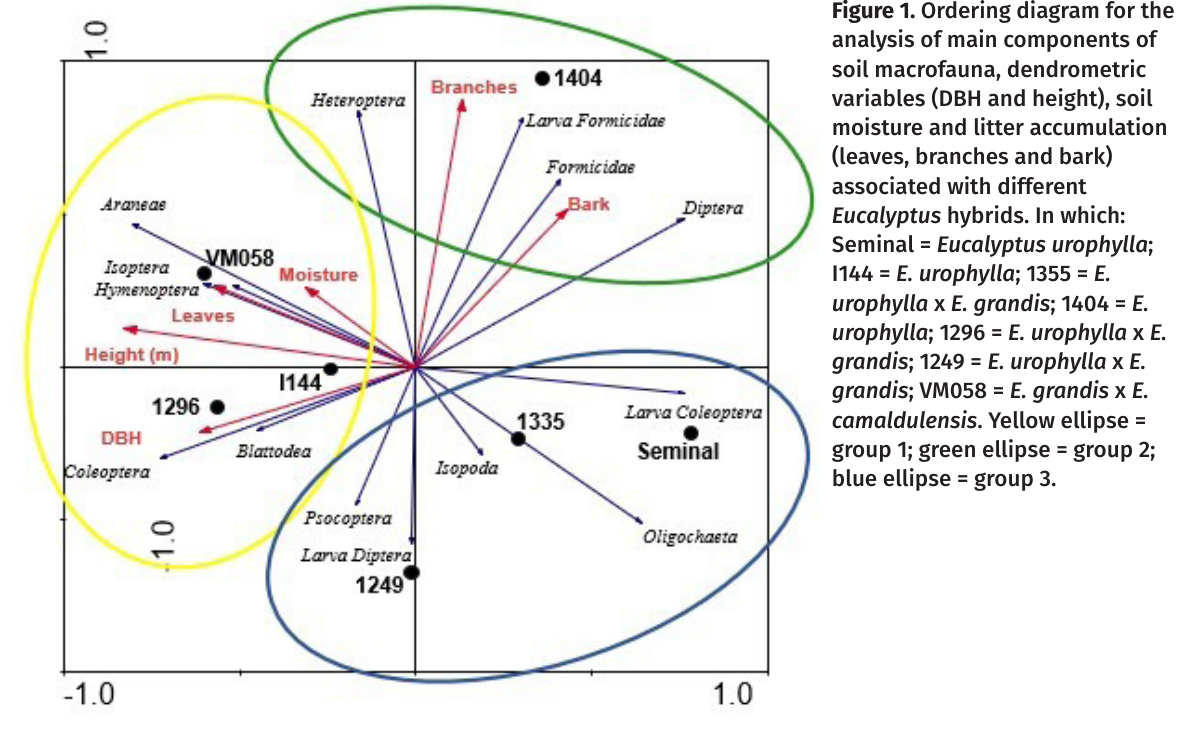
Figure 1. Ordering diagram for the analysis of main components of soil macrofauna, dendrometric variables (DBH and height), soil moisture and litter accumulation (leaves, branches and bark) associated with different Eucalyptus hybrids. In which: Seminal = Eucalyptus urophylla ; urophylla x E. grandis ; 1404 = E. urophylla ; 1296 = E. urophylla x E.